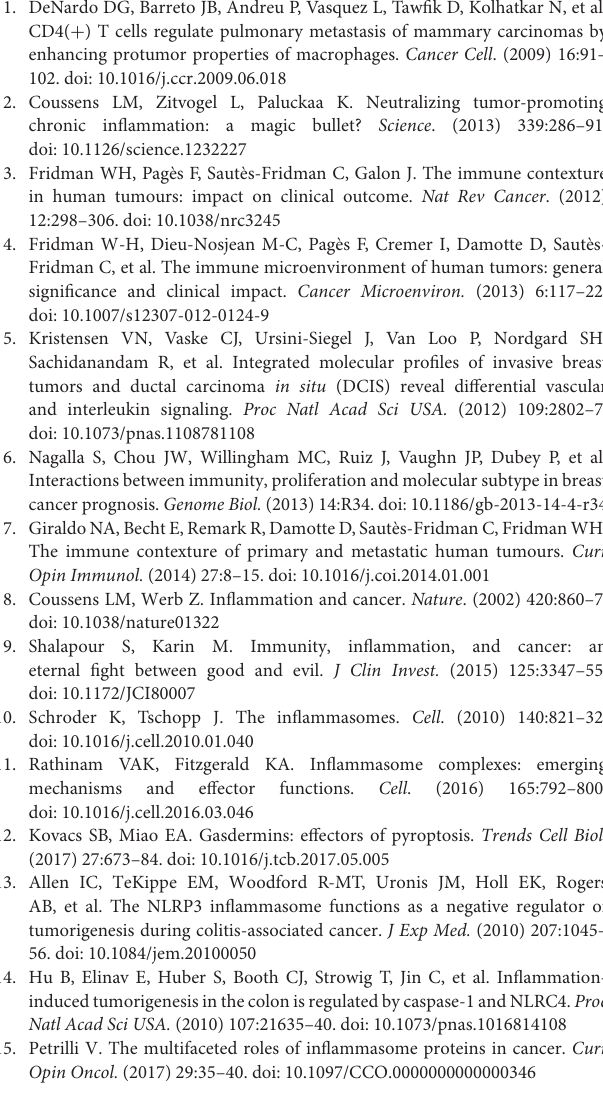
Correlation graph of NK cells vs. neutrophils infiltrated in 4T1 tumors isolated from WT ( n = 6), Caspase-1 KO ( n = 6), and Asc KO ( n = 6) mice 14 days post-injection. (C,D) Flow cytometry quantification and analysis of myeloid (C) and lymphoid (D) cell populations from WT, Caspase-1 KO, and Asc KO mice 7 days post-injection with 4T1 mammary tumor cells. (E,F) Flow cytometry quantification and analysis of myeloid (E) and lymphoid (F) cell populations in spleens from WT Supplementary Figure 2 | IL-1 β inhibition does not affect 4T1 tumor growth in vivo . WT mice were injected with IgG control ( n = 7) or anti-IL1 β antibody ( n = 8) the day before tumor inoculation and then twice a week. Treated mice were orthotopically injected with 4T1 mammary tumor cells. Tumor growth was measured over 28 days.